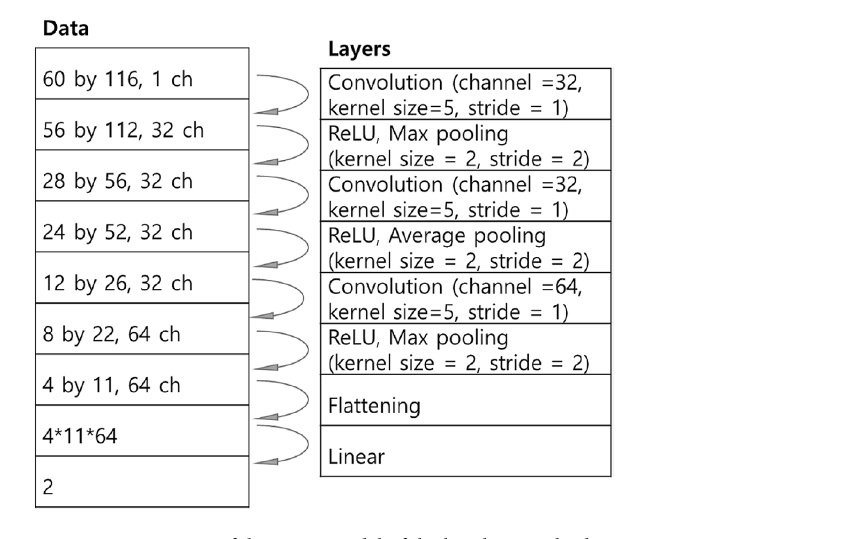
Figure 8. Structure of the CNN model of the baseline